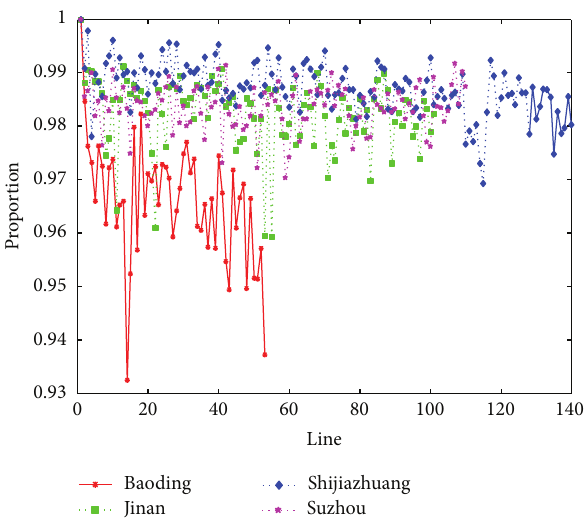
Figure 4: The total transfer proportion after deleting a line.